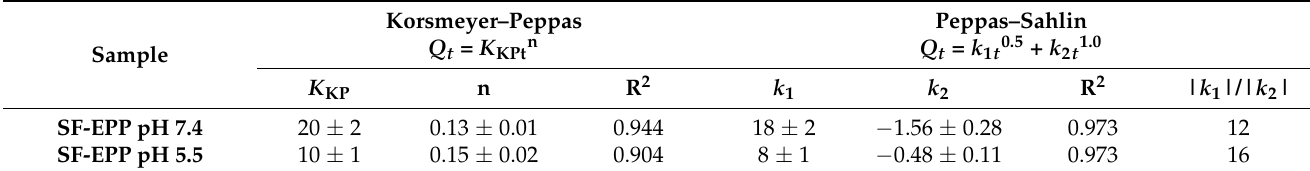
Table 3. Parameters and correlation coefficients for Korsmeyer–Peppas and Peppas–Sahlin